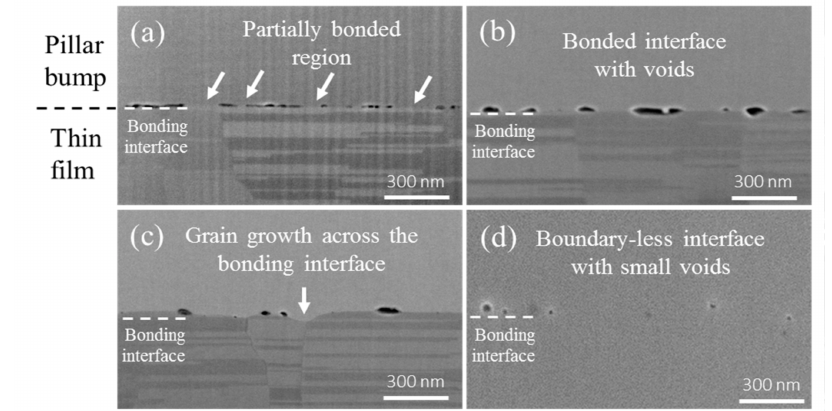
Figure 3. Cross-sectional secondary SEM images showing the microstructures in the bonding interface for the Cu joint bonded at ( a ) 200 ◦ C/100 ◦ C, ( b ) 250 ◦ C/100 ◦ C, ( c ) 300 ◦ C/100 ◦ C, and ( d ) 350 ◦ C/100 ◦ C.